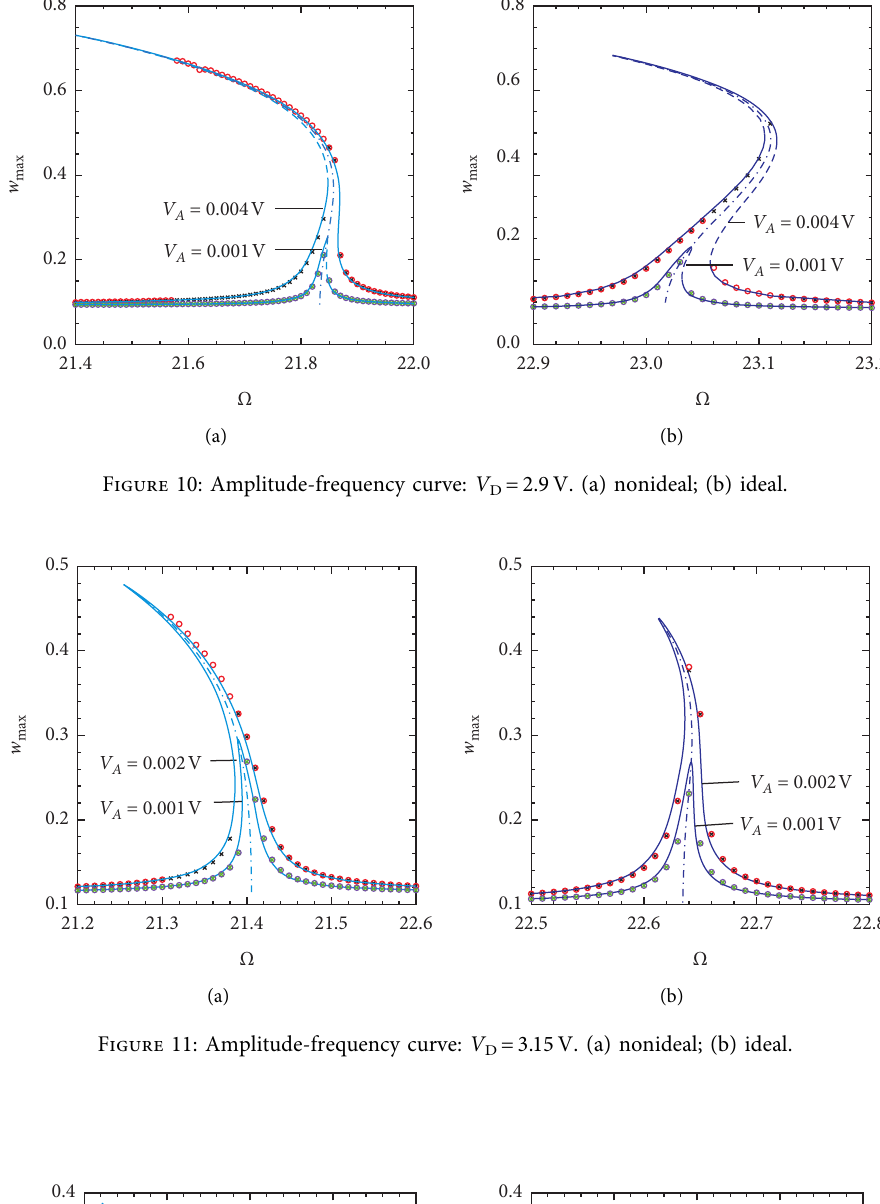
� 3.15V. (a) nonideal; (b) ideal. D